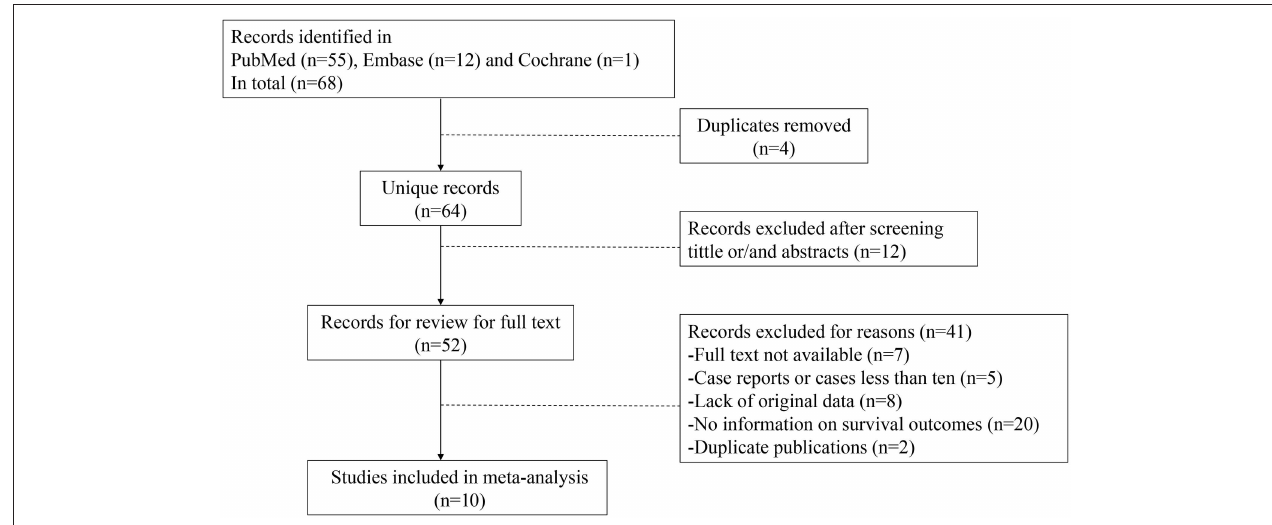
FIGURE 1 | Flowchart of screening process.